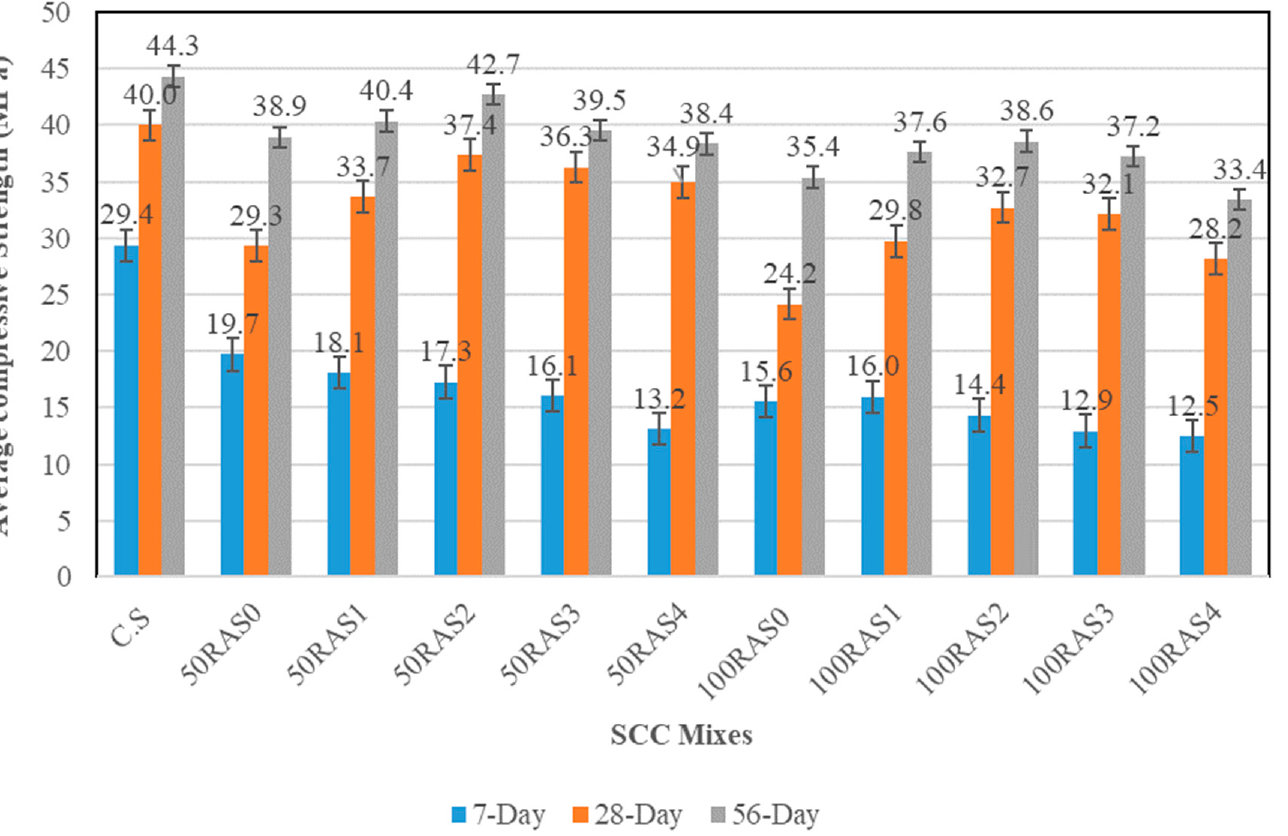
Figure 9. Average compressive strength results of SCC mixes .